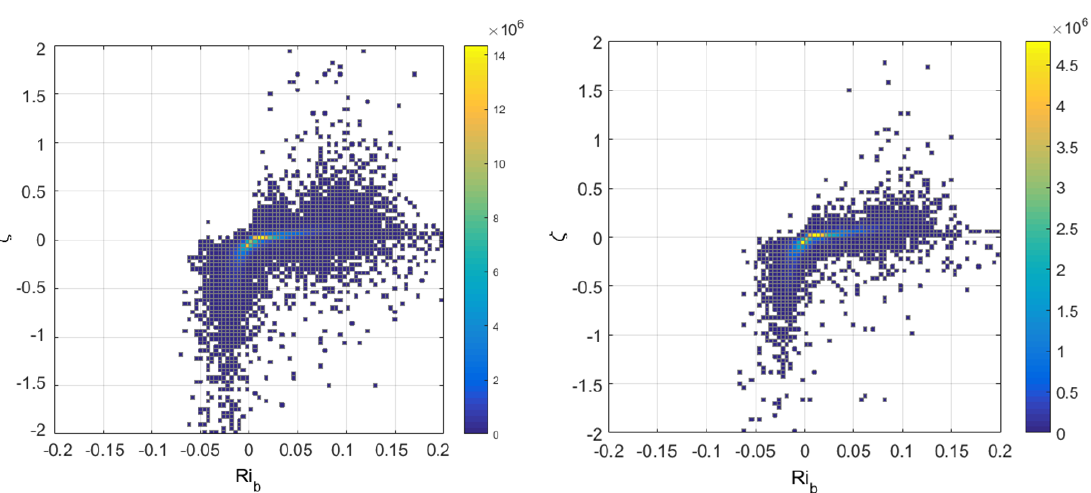
Figure 2. Distribution of Ri B and ζ MOST for two different time scales of 10 min (to the left ) and 30 min (to the right